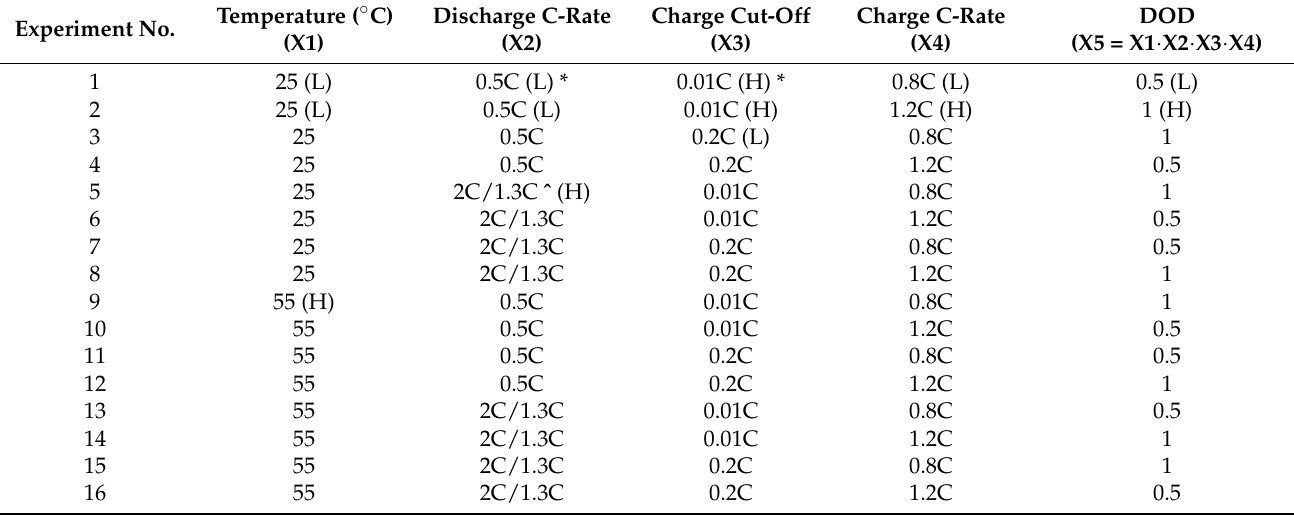
Table 1. Half-fractional factorial test